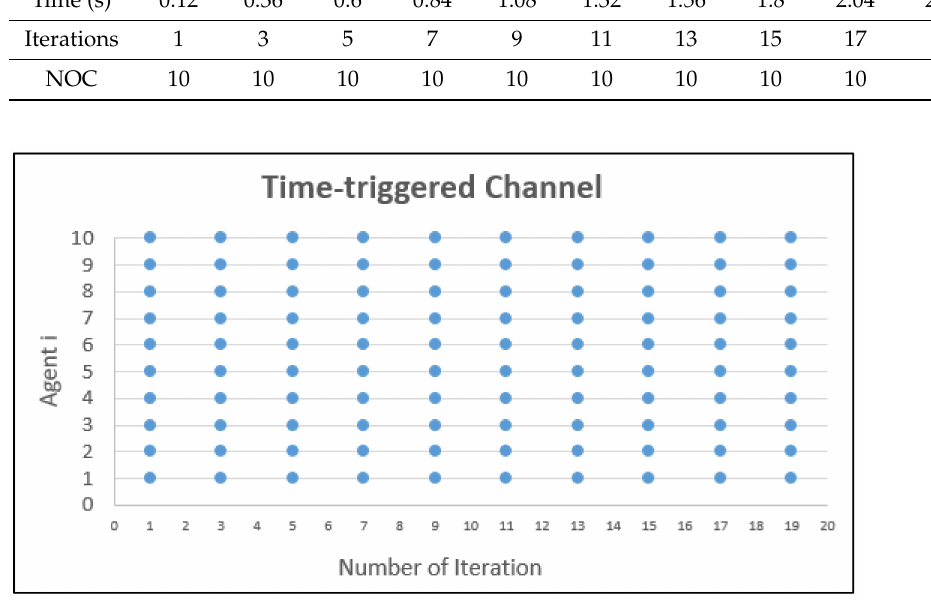
Figure 12. NOC per iteration